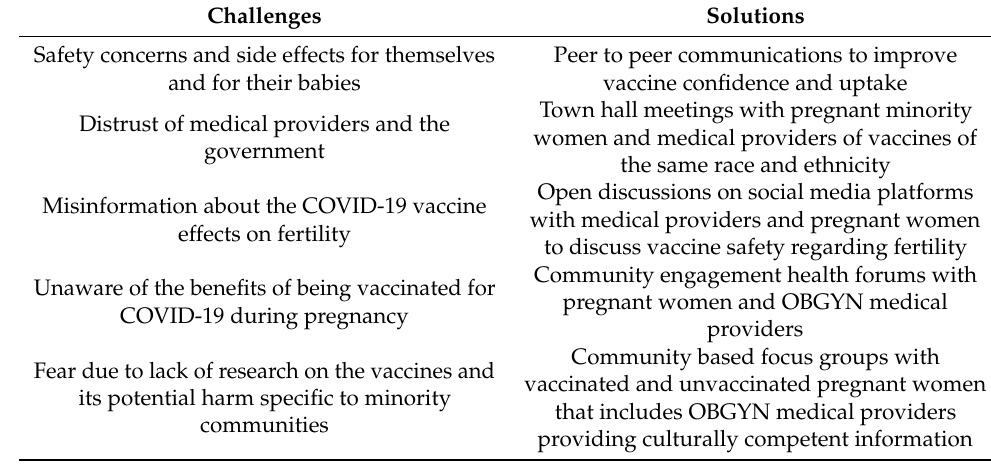
Table 1. Vaccine-related challenges and potential solutions among pregnant minority